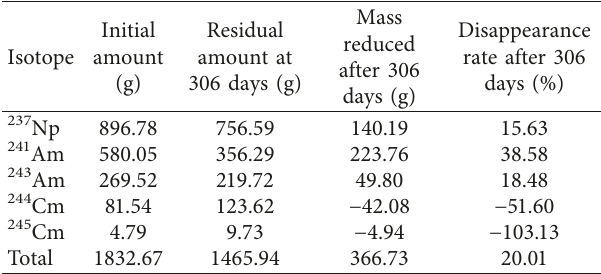
Table 4: Transmutation rate in case of homogeneous loading with 10wt.% of